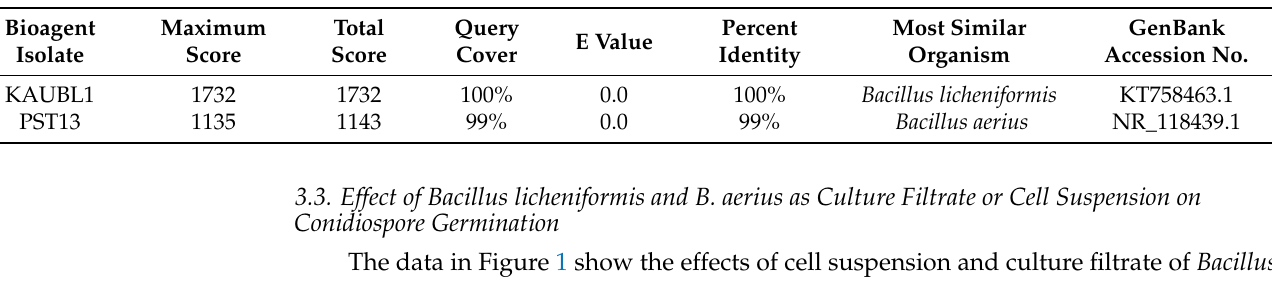
Table 2. Molecular characterization of unknown isolates by 16S rRNA